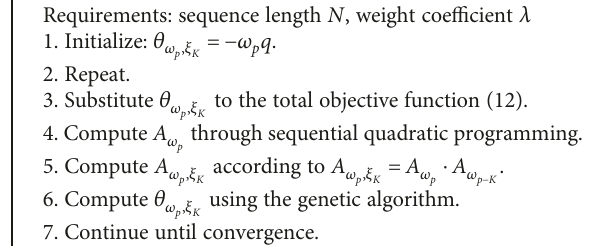
Algorithm 1: Signal spectrum under the condition of optimal detection criteria for a speci fi c Doppler ξ